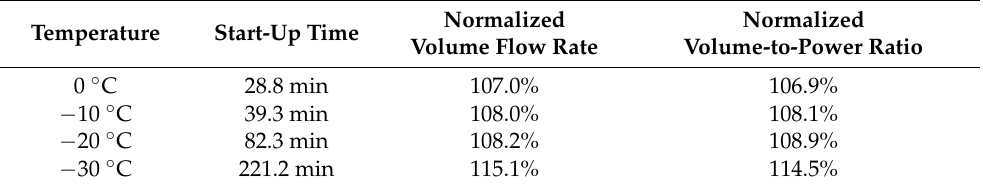
Table 2. Main results averaged after the closing of the anti-condensation valve that recirculates compressed and hot air, when the oil temperature reaches 50 ◦